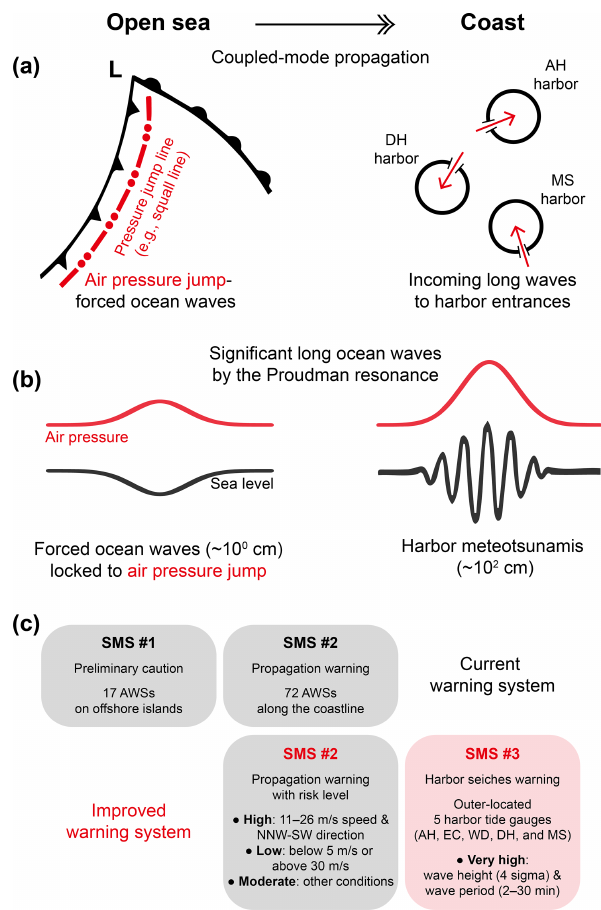
Figure 11. (a) Schematic diagram of harbor meteotsunamis, (b) the amplification process of ocean waves locked to air pressure jumps in the time domain, and (c) the meteotsunami warning system (as is and to be) in the eastern Yellow